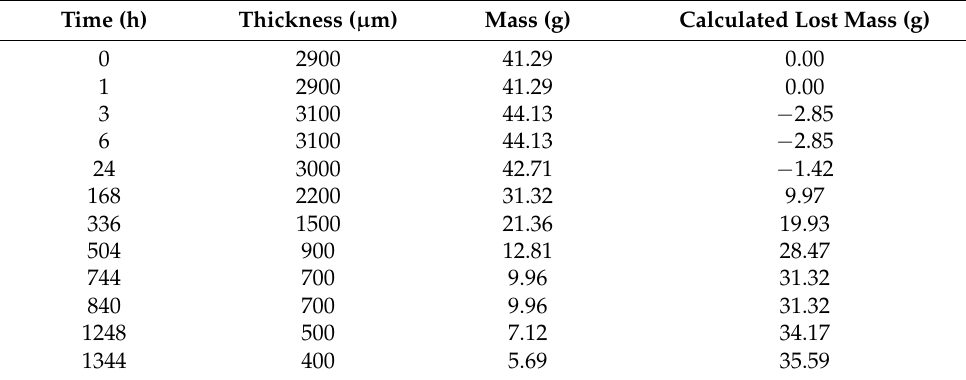
Table 1. Determination of calculated lost mass through ultrasound measurements.